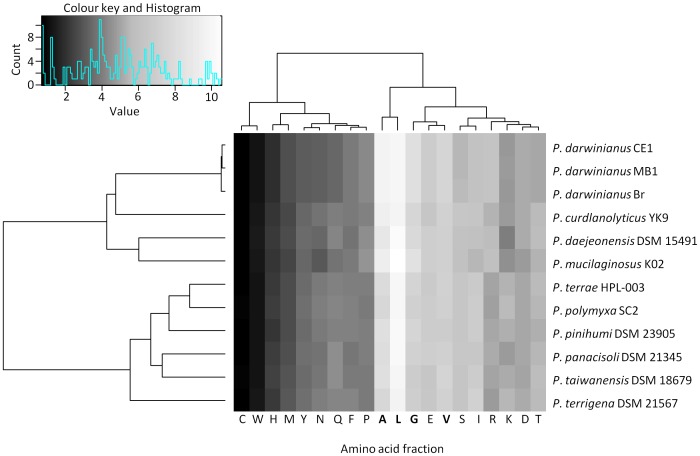
Amino acid usage heatmap of temperate Paenibacillus spp. and P. darwinianus strains.